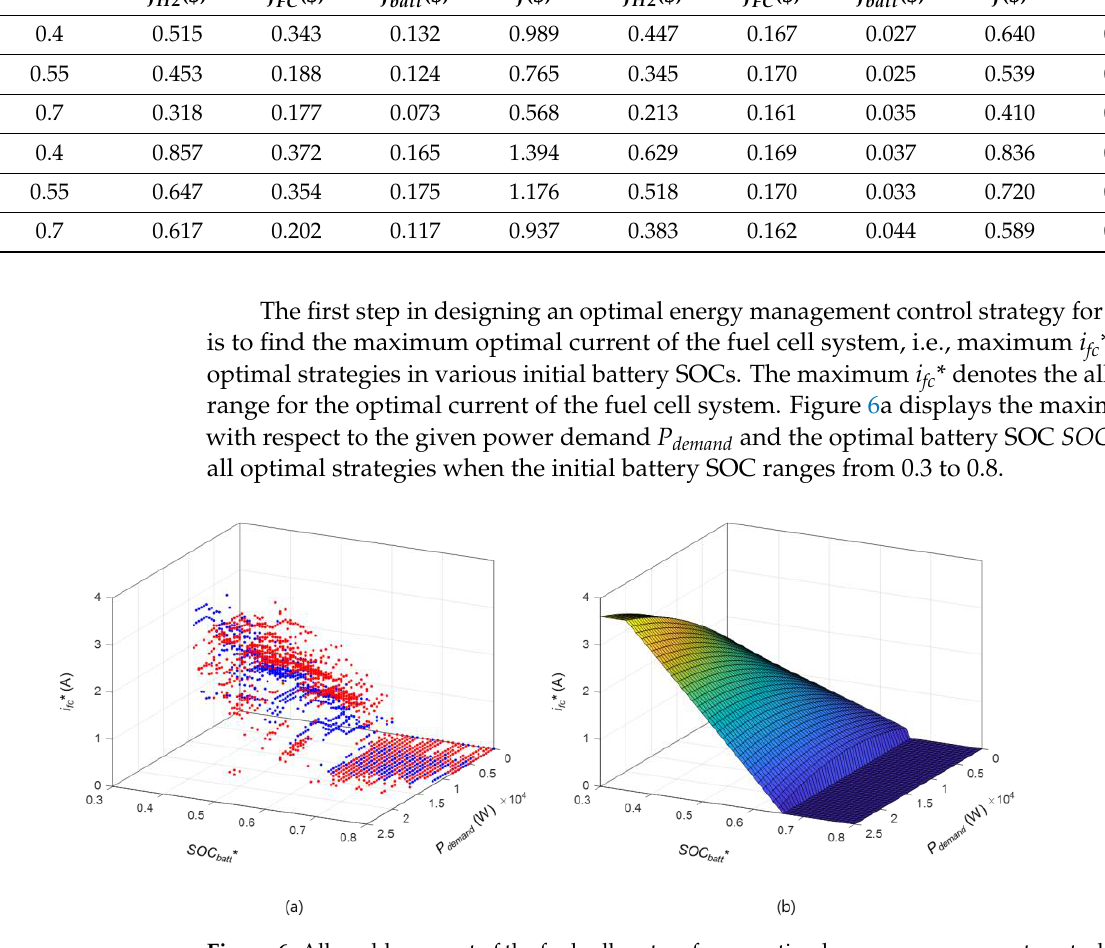
Figure 6. Allowable current of the fuel cell system for an optimal energy management control strategy: ( a ) Maximum i fc * with respect to the given P demand and the SOC batt *(Blue color represents the NEDC cycle and red color represents the WLTC cycle); ( b ) Allowable i fc *.